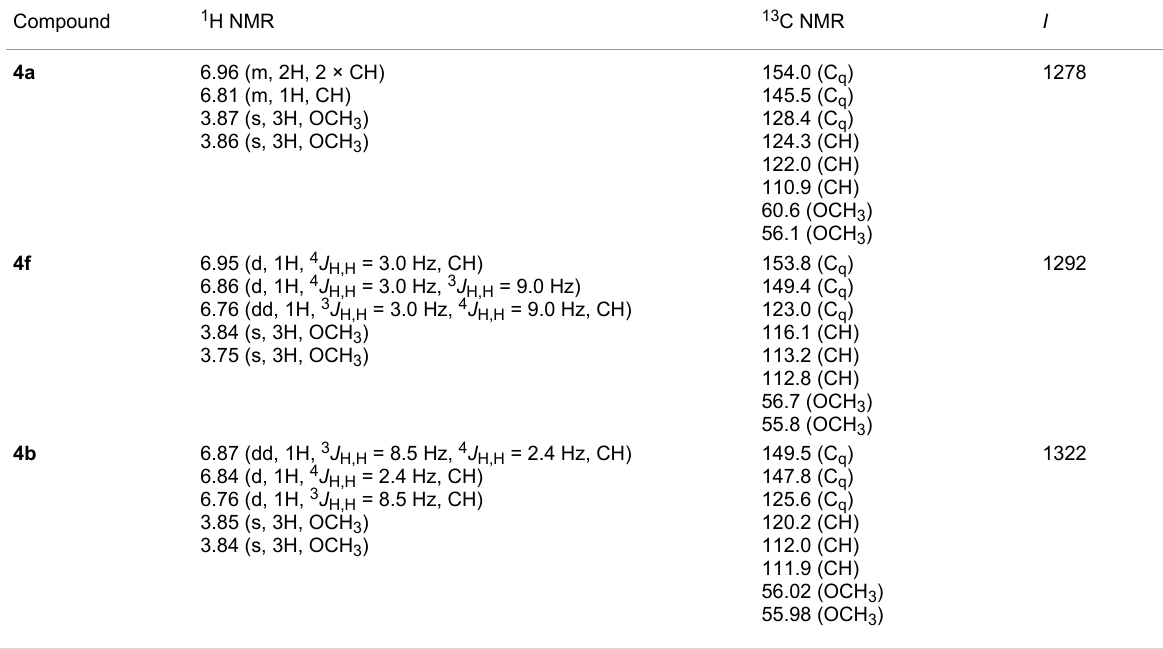
Table 2: NMR spectroscopic data and GC retention indices of all constitutional isomers of chlorodimethoxybenzene in comparison to natural X .